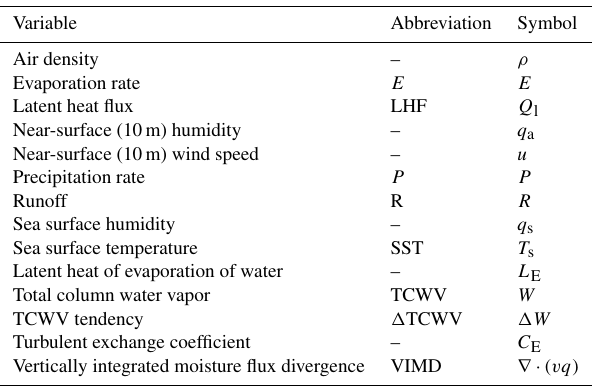
Table 2. Abbreviations and symbols of variables used throughout the